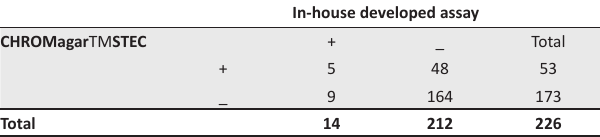
FIGURE 8: Summary of isolate characterisation results. TABLE 3: Performance of CHROMagar TM STEC compared with real-time polymerase chain reaction